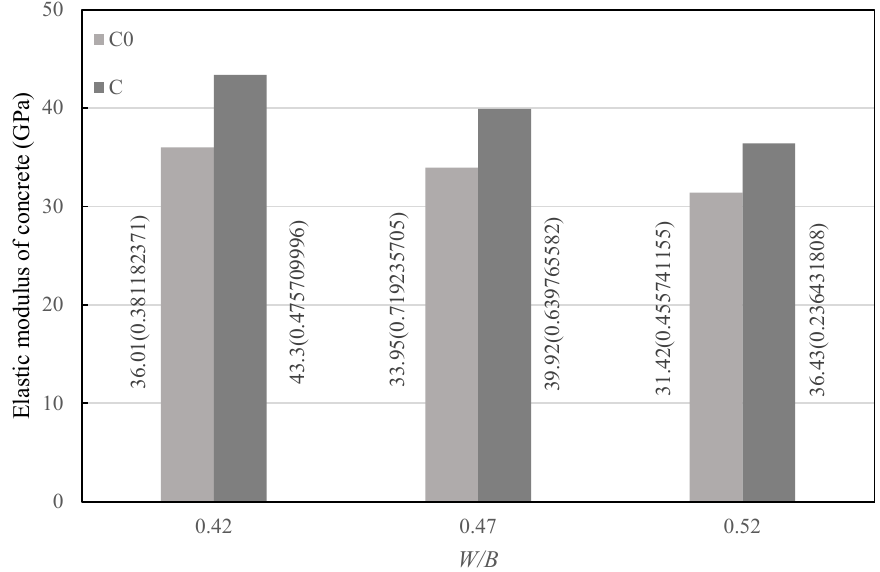
Figure 3. Elastic modulus of concrete.